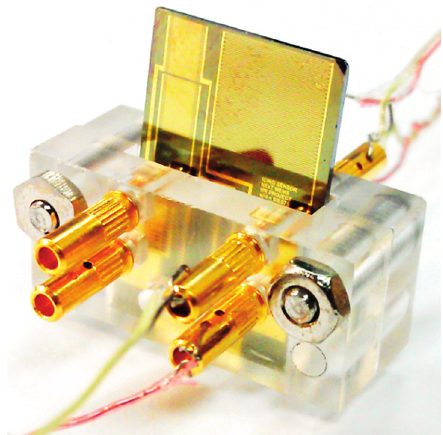
Figure 8. Picture of the plastic packaged ice